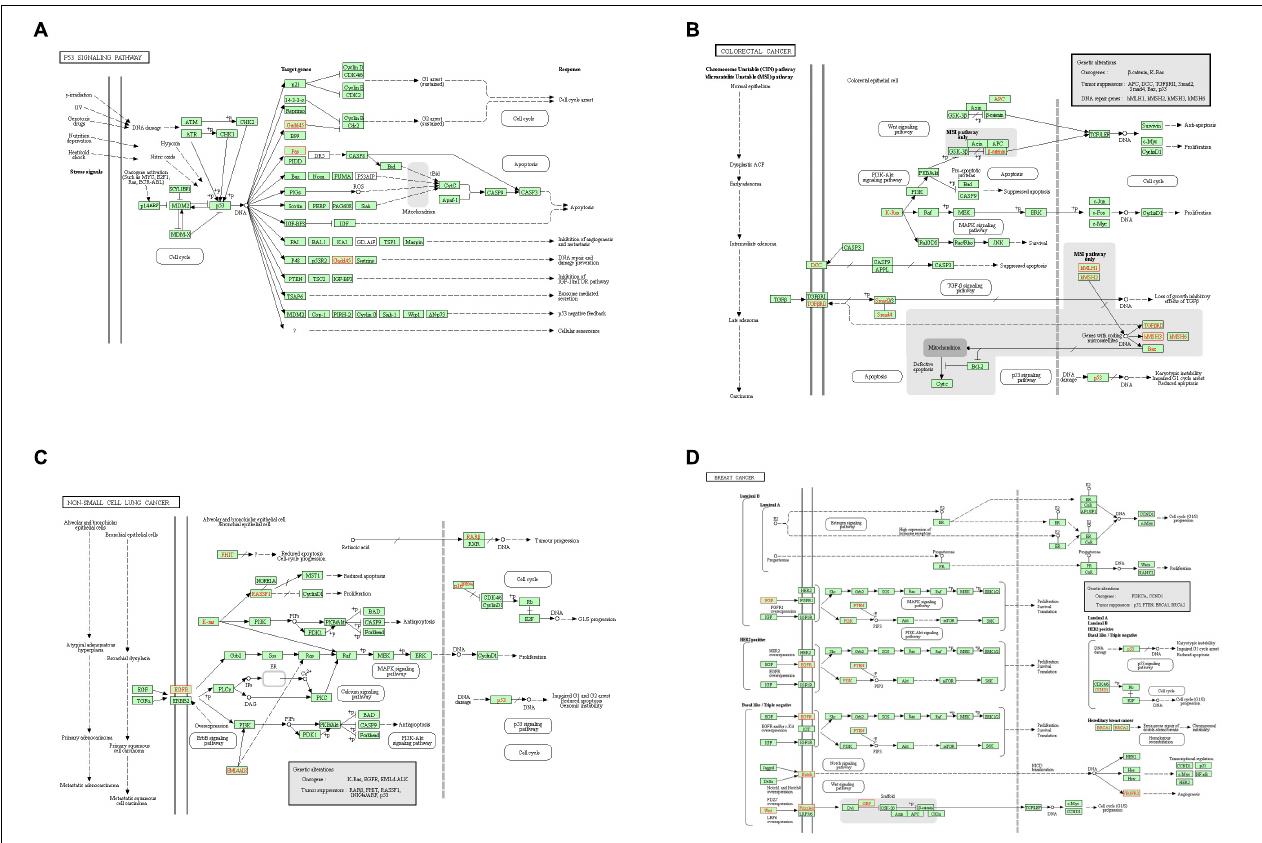
FIGURE 3 | Unigenes predicted to be involved in the p53 signaling pathway (A) , colorectal cancer pathway (B) , non-small cell lung cancer pathway (C) , and breast cancer pathway (D) . Red indicates significantly different expression in infected group compared with control